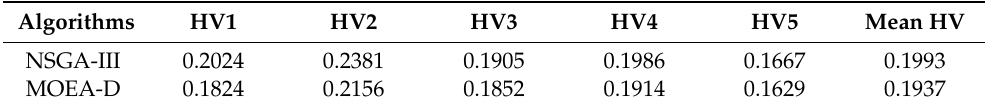
Table 11. Comparison of the HV indicators of the evolutionary multi-objective optimization solution set.